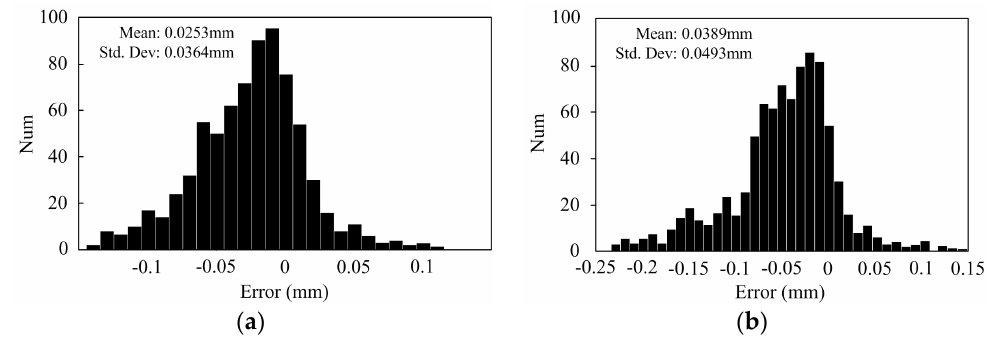
Figure 16. Histogram of the measurement error of the 20 mm distances by: ( a ) the proposed method; and ( b ) the method in [29].